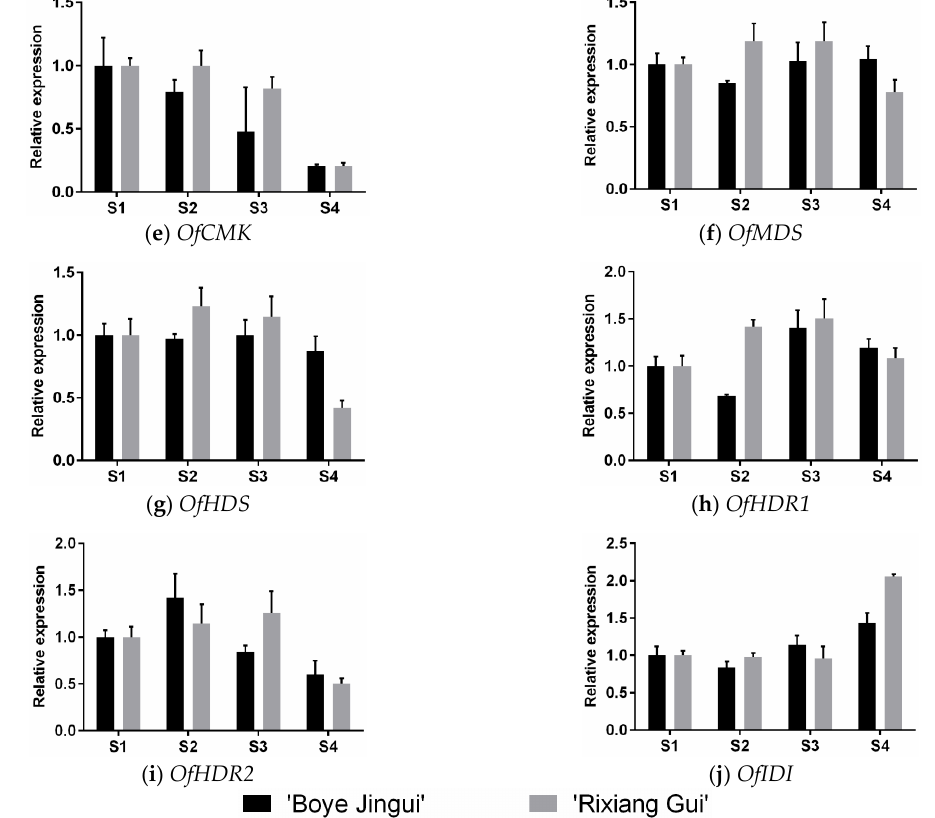
Figure 4. Expression patterns of MEP pathway genes at four different flowering stages of Osmanthus fragrans . These cDNA templates were isolated from bud ‐ eye stage (S1), primary blooming stage (S2), full blooming stage (S3), flower fading stage (S4). Data were presented as means with error bars indicating standard deviation.